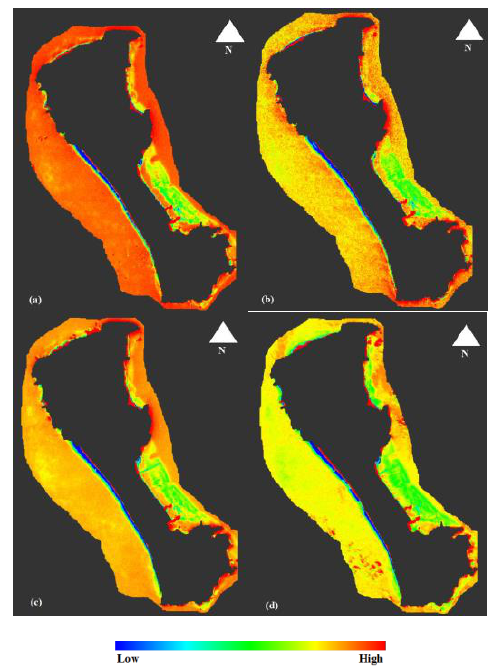
Figure 14: Processed Floating Algae Index (FAI) on the inner coast of Boracay Island for (a) April 25 (b) May 18 (c) July 4 (d) October 5 In Figure 15 above showed the distribution of FAI values of the four datasets. Red areas had high values of FAI while blue areas had low FAI values. From April 25 (a) to May 18 (b), the color of the coast changed from red-orange to mostly yellow